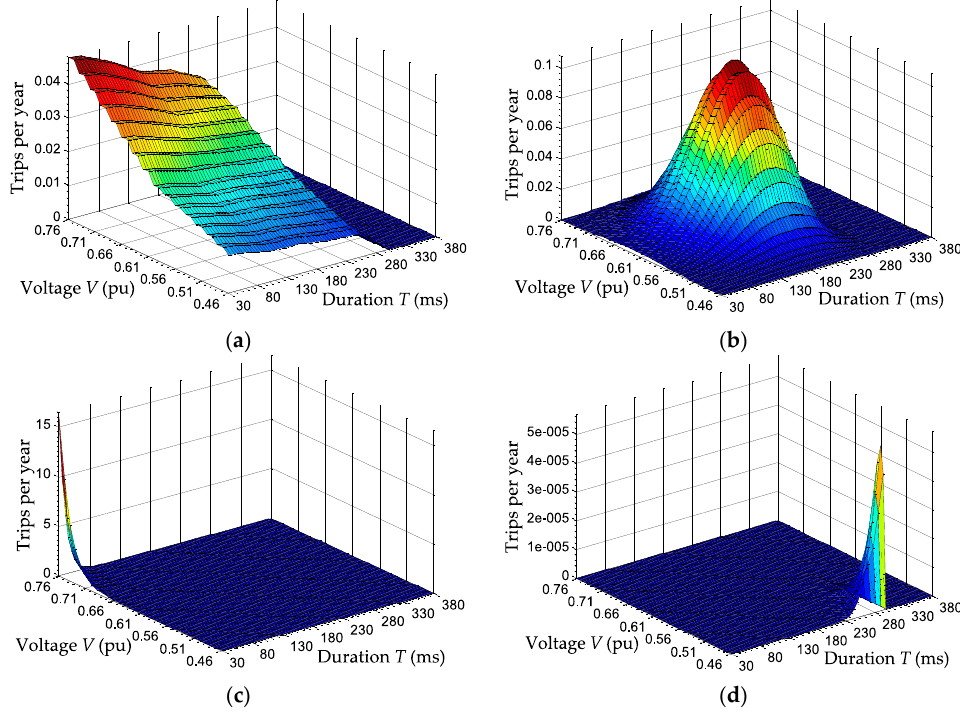
Figure 21. Number of expected trips per year of various voltage–tolerance characteristics for PLC: General probability method ( a ) uniform; ( b ) normal; ( c ) exponential; and ( d ) reverse exponential.